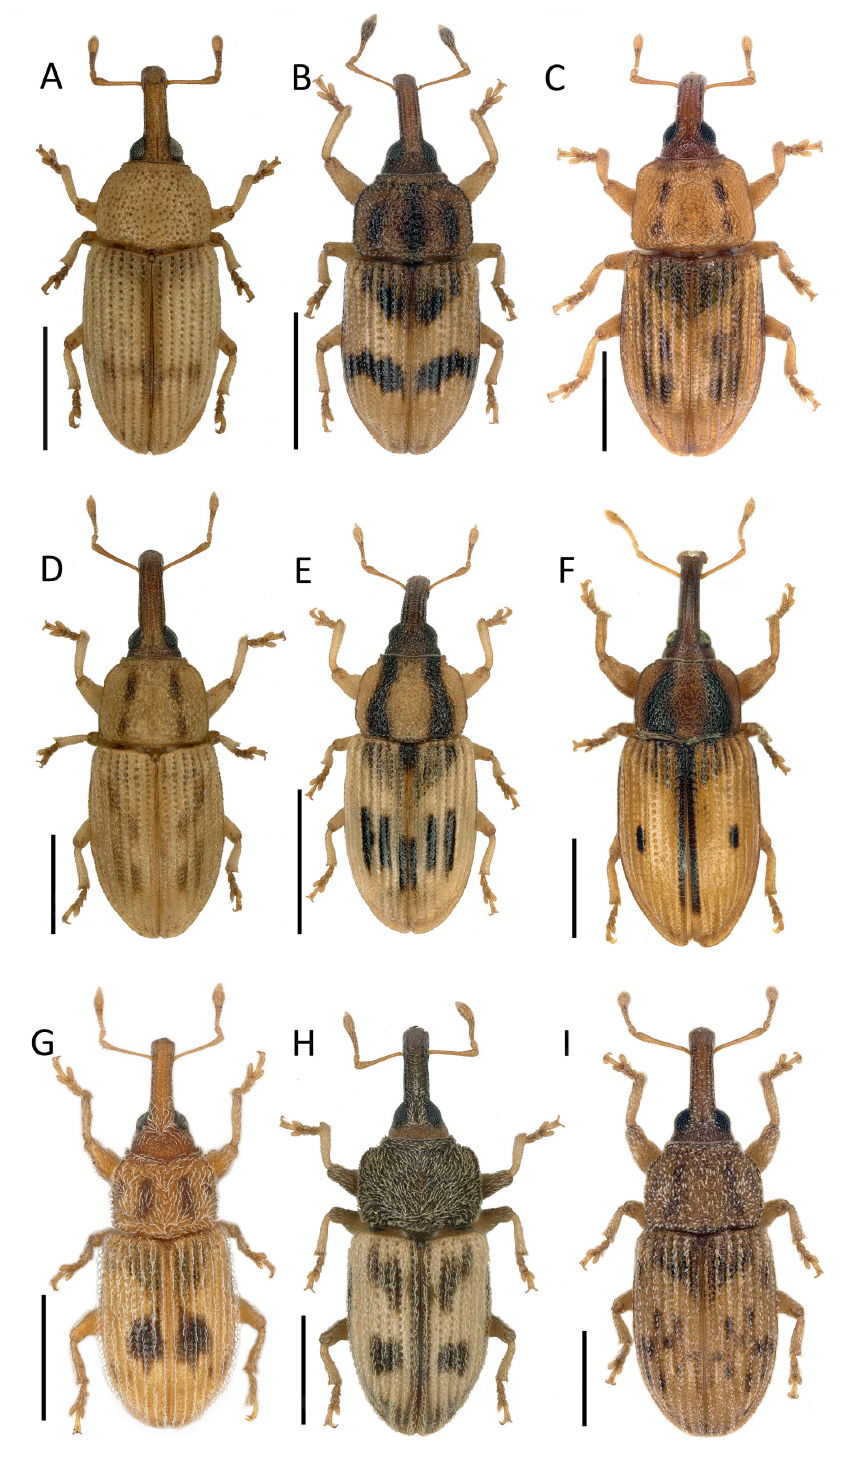
Fig. 3. A–I . Habitus of males of Ebenacobius Haran gen. nov. in dorsal view (part 2). A . E. mulanjensis Haran gen. et sp. nov. B . E. hessei Haran gen. et sp. nov. C . E . pedi Haran gen. et sp. nov. D . E . tsonga Haran gen. et sp. nov. E . E . hippopotamorum Haran gen. et sp. nov. F . E . incognitus (Hesse, 1929) gen. et comb. nov. G . E. oberprieleri Haran gen. et sp. nov. H . E . turneri (Marshall, 1935) gen. et comb. nov. I . E . rhodesianus (Hesse, 1929) gen. et comb. nov. Scale bars = 1